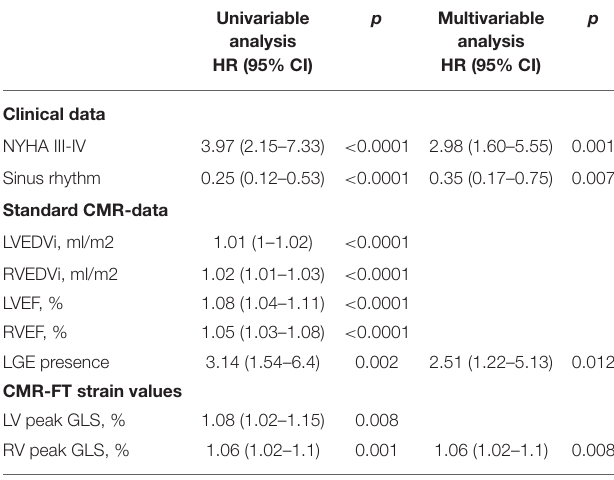
TABLE 2 | Baseline CMR-FT parameters of the study population according to experience of the primary end-point * . All patients Patients with ( n = 273) MACEs